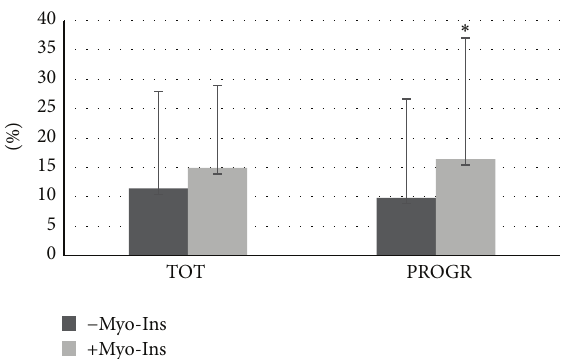
Figure 3: Sperm motility of thawed samples. Values are shown as mean ± SD. Statistical difference between pre- and post-Myo-Ins treatment: ∗ 𝑝 ≤ 0.05 .